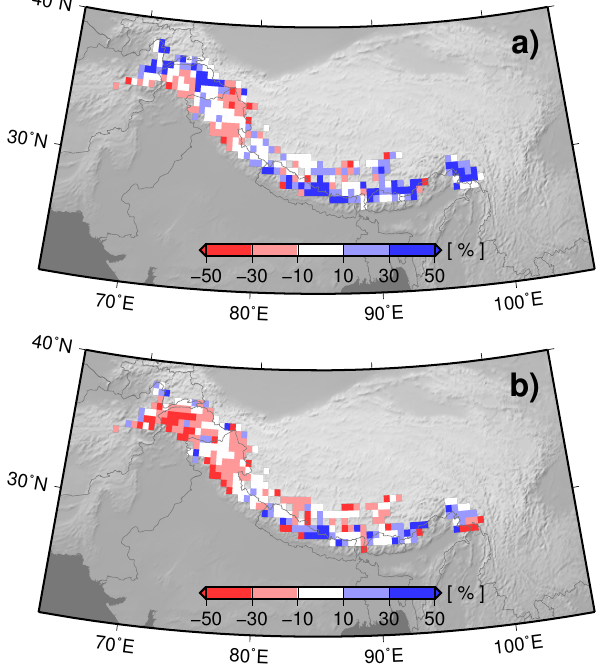
Figure 18. Normalised differences between glacier area in the (a) upper and (b) lower zones of the ICIMOD inventory and GGI for each 0.5 ◦ grid cell in the Hindu Kush–Himalaya